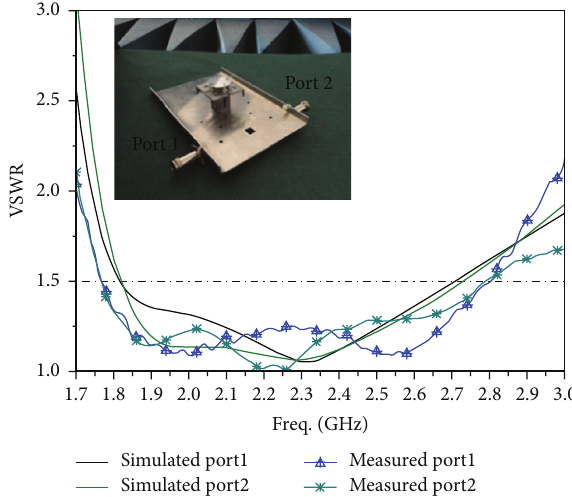
Figure 5: Simulated and measured VSWR against frequency.